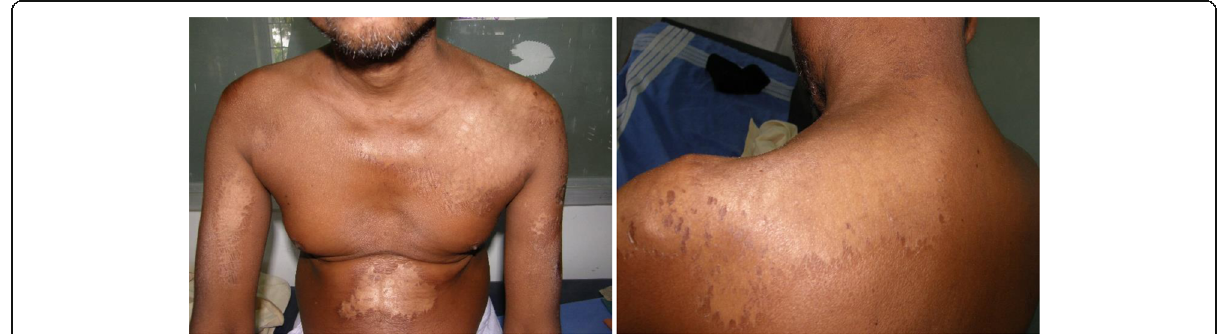
Fig. 3 Improvement of the skin lesions after the commencement of the